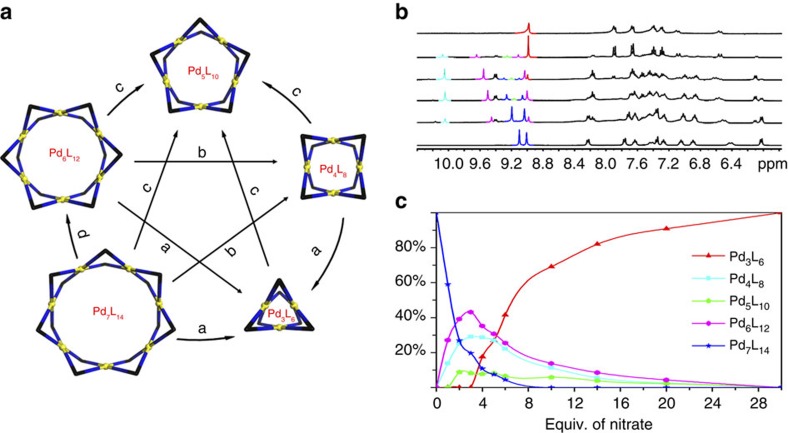
Induce-fit transformations between macrocycles.(a) Cross map showing all the transformations between the macrocyclic species (conditions for a: NO3− ; b: HSO4−; c: Mo7O246−; d: BF4−); (b) 1H NMR (400 MHz, [D6]DMSO, 298 K) titration spectra showing the gradual transformation from the heptanuclear complex 6a to the trinuclear complex 2 by sequential addition of KNO3 (bottom up: 0, 1, 2, 4, 10, 30 eq.) with He signals highlighted for Pd3L6: red, Pd4L8: sky blue, Pd5L10: green, Pd6L12: pink and Pd7L14: dark blue, respectively; (c) Composition distributions for all the PdnL2n species obtained by the integrals of the He signals from the titration experiment.